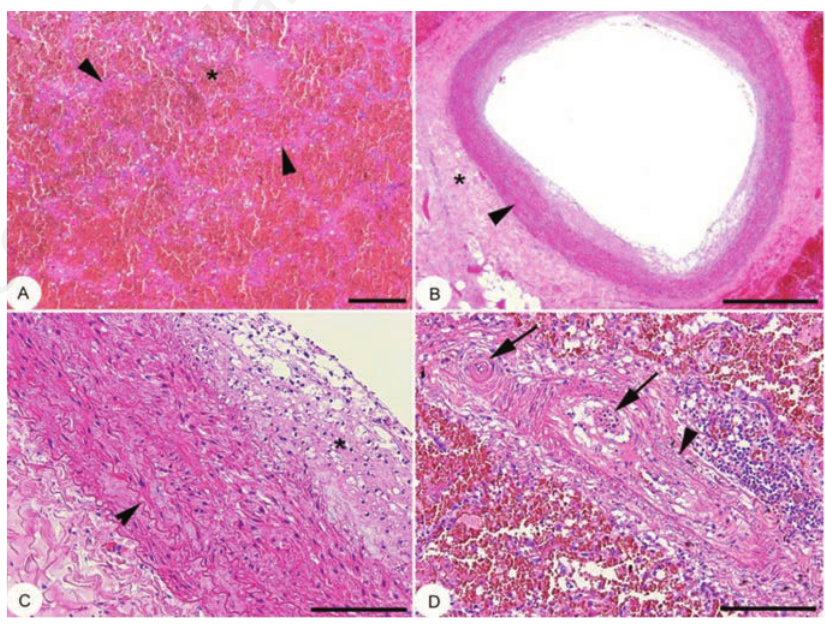
Figure 3. Histopathology. A) The lung parenchyma is diffusely modified by an endoalveolar hemorrhage (asterisk) which is delimited by the alveolar septa with exceedingly congested blood vessels (arrowheads). B) The greatest pulmonary artery roots display thickening of their wall (arrowhead) and periadventitial fibrosis (asterisk). C) In this close-up of picture B, the blood vessel wall is thickened as a result of tunica media (arrowhead) and tunica intima (aster- isk) enlargement. The tunica media shows increased elastic fiber and smooth muscle cell com- ponents, thereby constituting a kind of arterialization. The tunica intima is characterized by fibrosis with edema and some mild inflammatory infiltrate. D) The peripheral pulmonary artery branches show marked thickening which is mainly secondary to smooth muscle cell pro- liferation. As a result, the relevant vessel lumens (arrows) are exceedingly narrowed. Hematoxylin-eosin staining. Original magnifications: A) x4 (bar 400